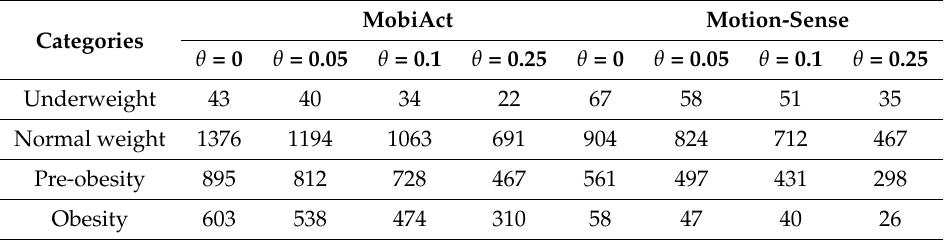
Table 6. Total number of sub-sequences (samples) in the jogging state selected by data